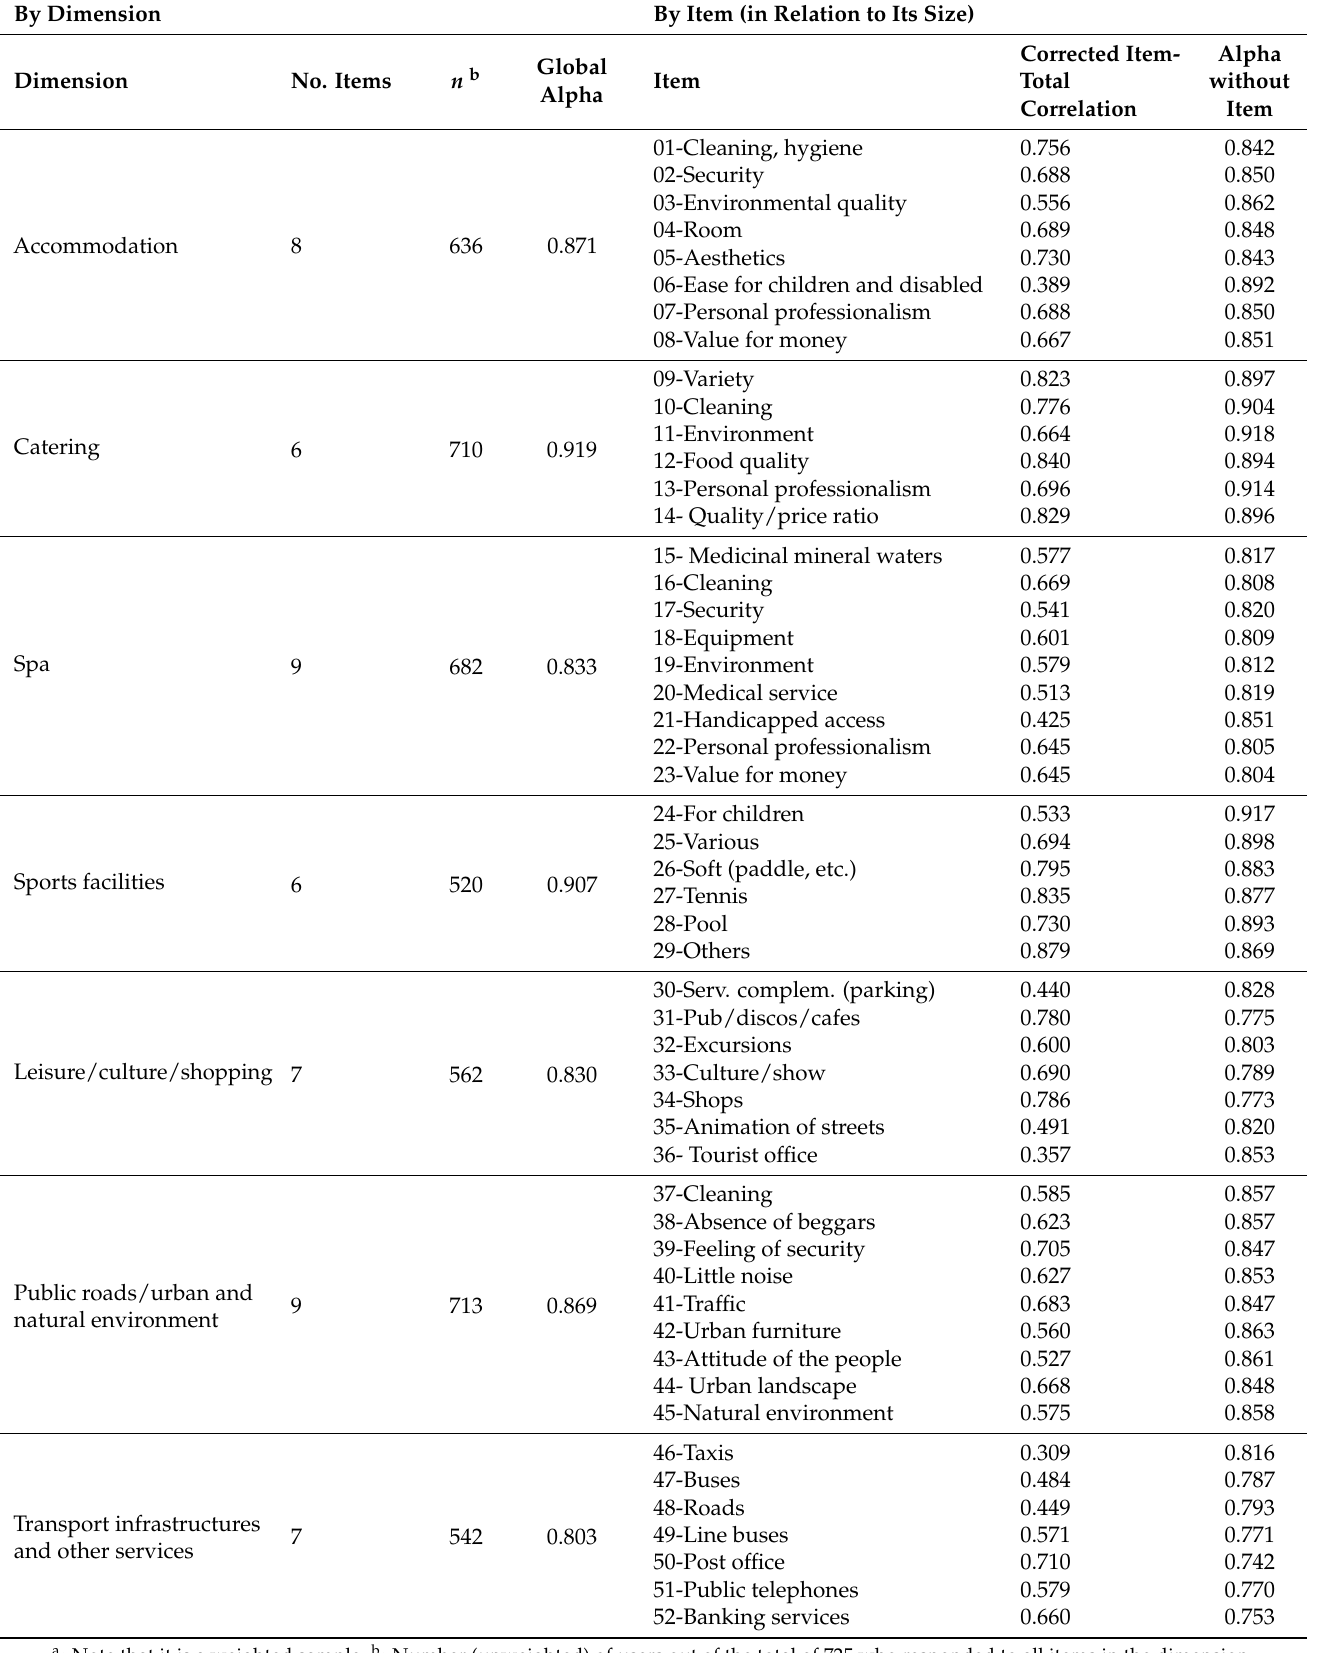
Table 5. Internal reliability of the questionnaire (Cronbach’s alpha) ( n = 725) a . By Dimension By Item (in Relation to Its